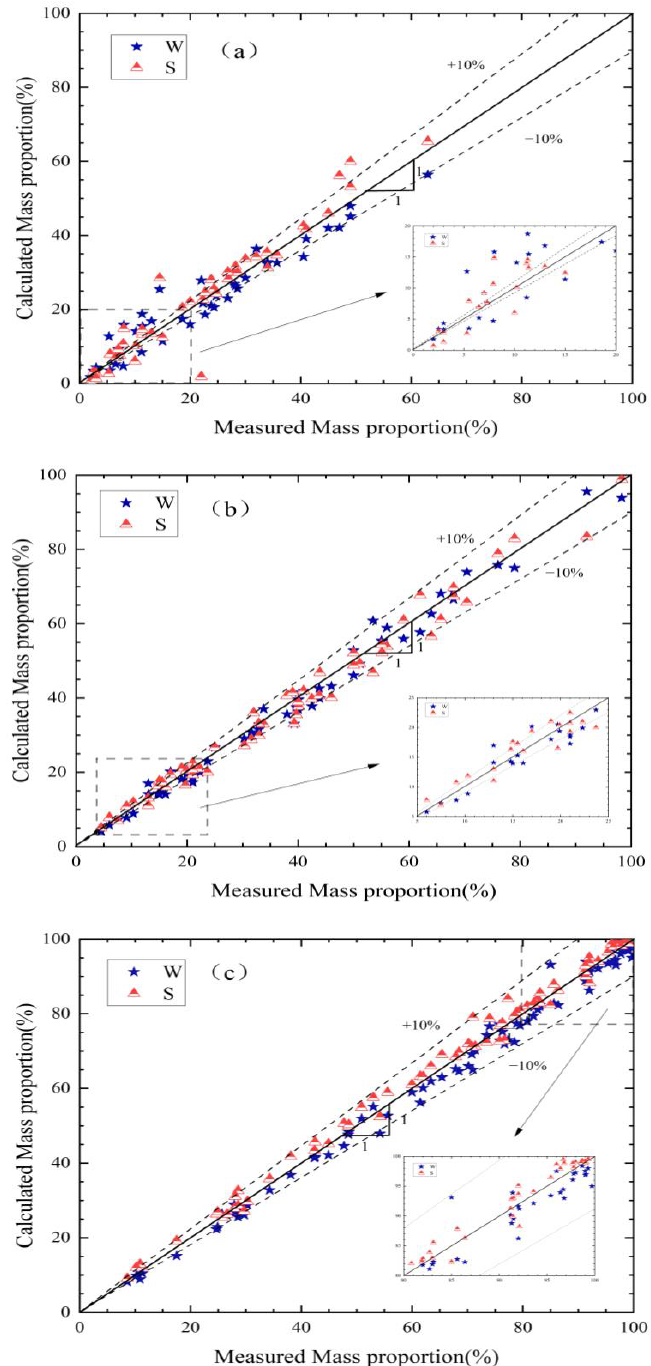
Figure 6. Results of the fitting accuracy of the W model and the S model: ( a ) clay, ( b ) silt, ( c ) sand. R 2 : ( a ) clay W (0.8803), S (0.8932), ( b ) silt W (0.9707), S (0.9759), ( c ) sand W (0.9735), S (0.9758).